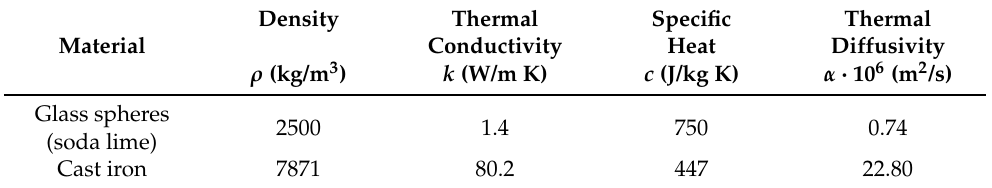
Table 1. Thermophysical properties (at T = 25 ◦ C) of the materials of the steam chamber.